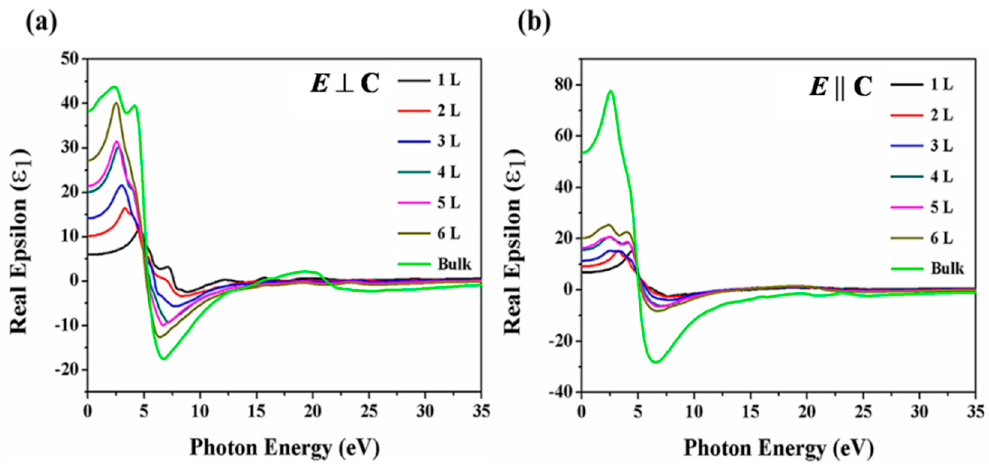
Figure 5. Calculated real part of the dielectric function along ( a ) Ε ⊥ C and ( b ) Ε || C polarization directions of the few-layer Te and bulk Tellerium.